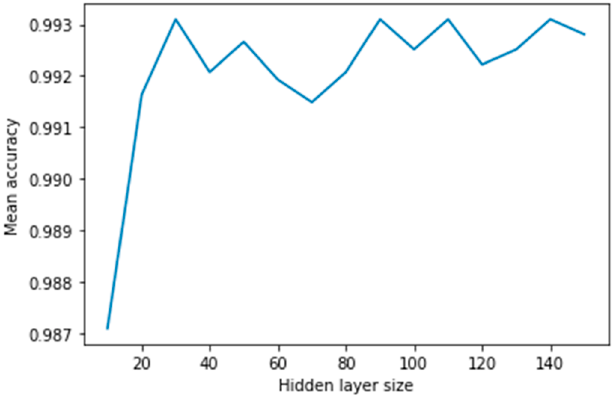
Figure 7. Mean accuracy of the random clicker classifier depending on the number of neurons in the hidden layer.